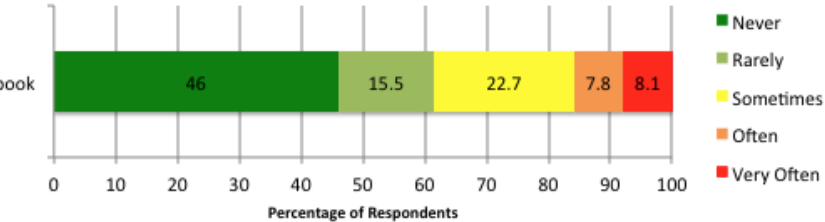
Figure 2. Frequency with which respondents do not purchase a required course textbook.